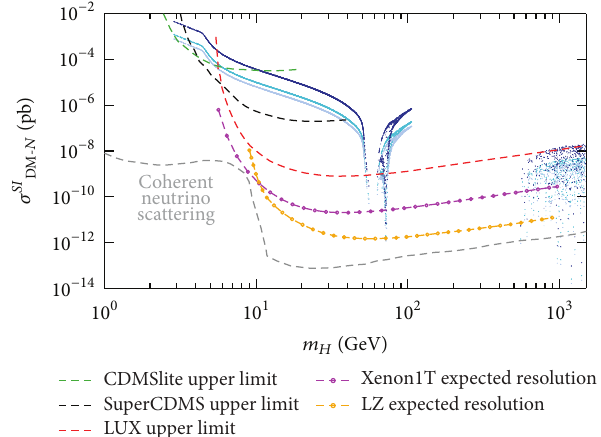
Figure 8: Spin-independent DM-nucleon cross section as a func- tion of the DM candidate mass, for points of the IHDM with DM relic density consistent with observation. Three scenarios are considered with different values for the form factor 𝑓 𝑁 . Lower bounds for past experiments and prospects of measurements for future experiments are